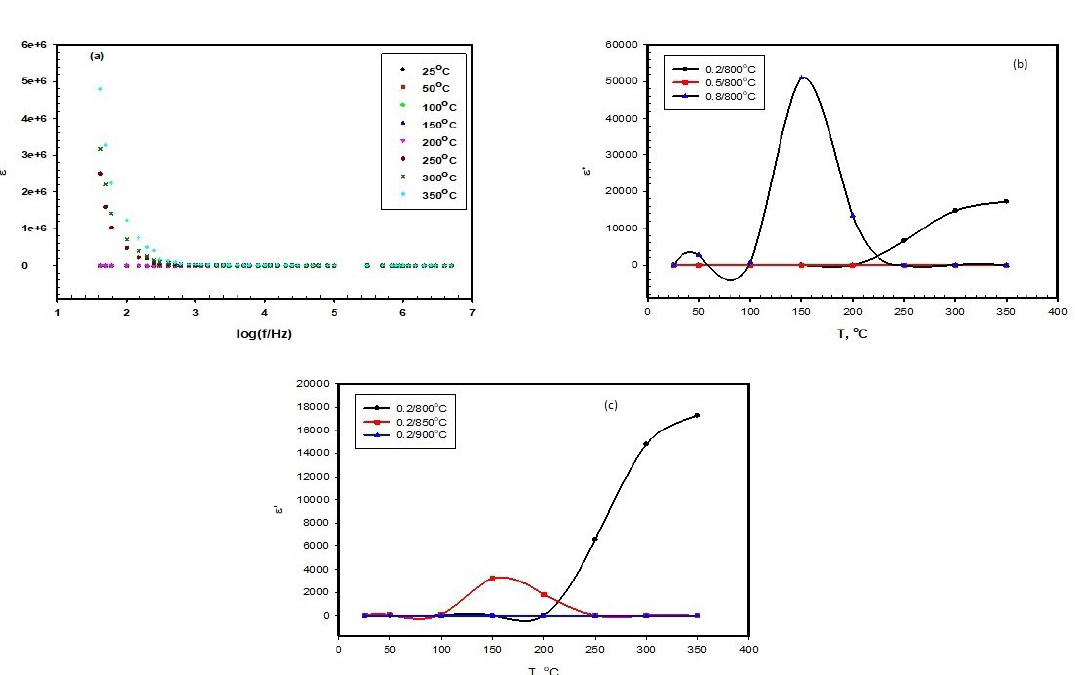
Zn Fe O prepared by solid state and 0.2 0.8 2 4